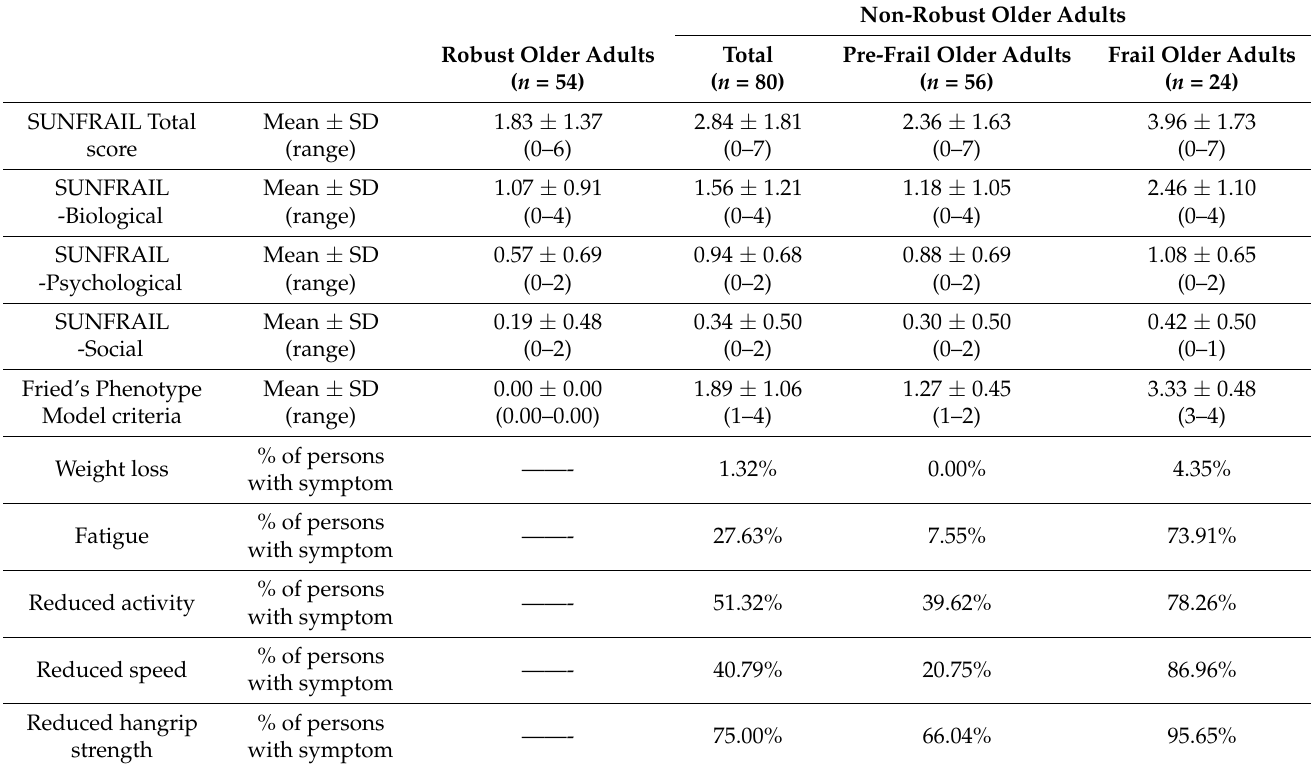
Table 2. SUNFRAIL score and diagnostic criteria for frailty based on Fried’s Phenotype